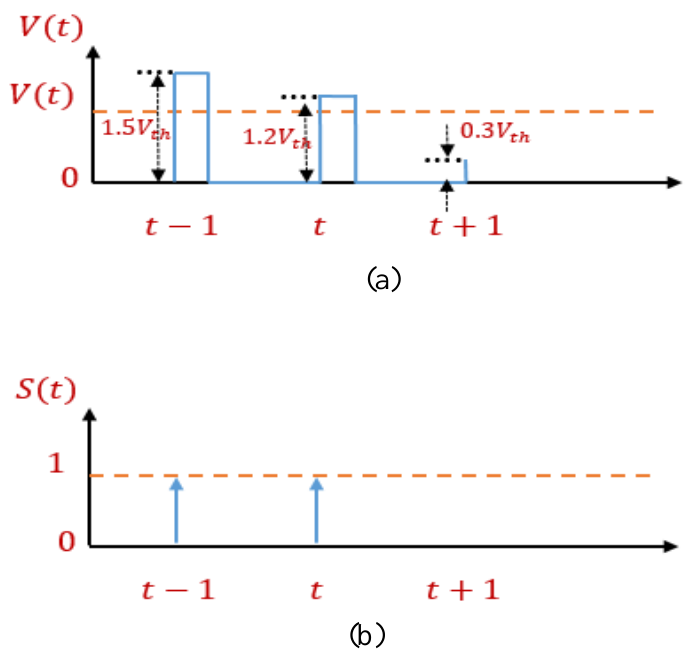
Figure A1. The IF neuron model. ( a ) a IF neuron driven by a set of input neurons via weights; ( b ) spiking behavior of IF